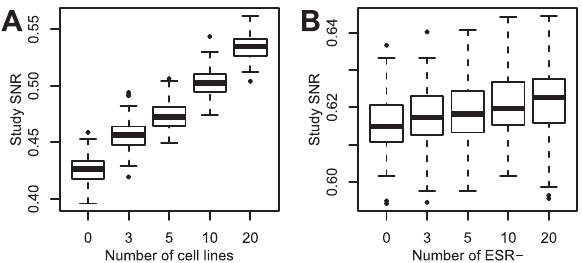
Figure 3. Effect of biological outliers on study SNR. The study SNRs were calculated in function of the number of biological outliers added to a study consiting of homogeneous samples. ( A ) Outliers are cell lines, original study consists of tumor and normal tissues. ( B ) Outliers are ESR 2 breast cancers, original study consists of ESR + breast cancers.